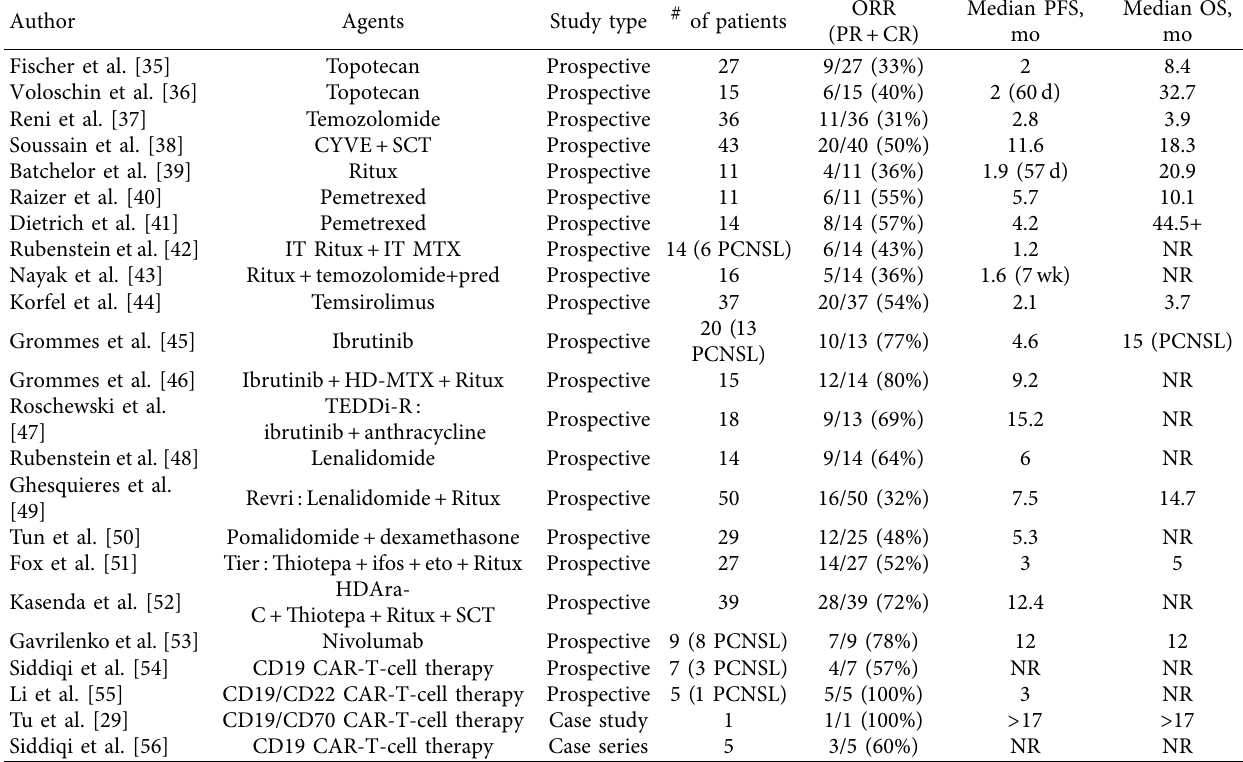
Table 2: Agents with activity in R/R